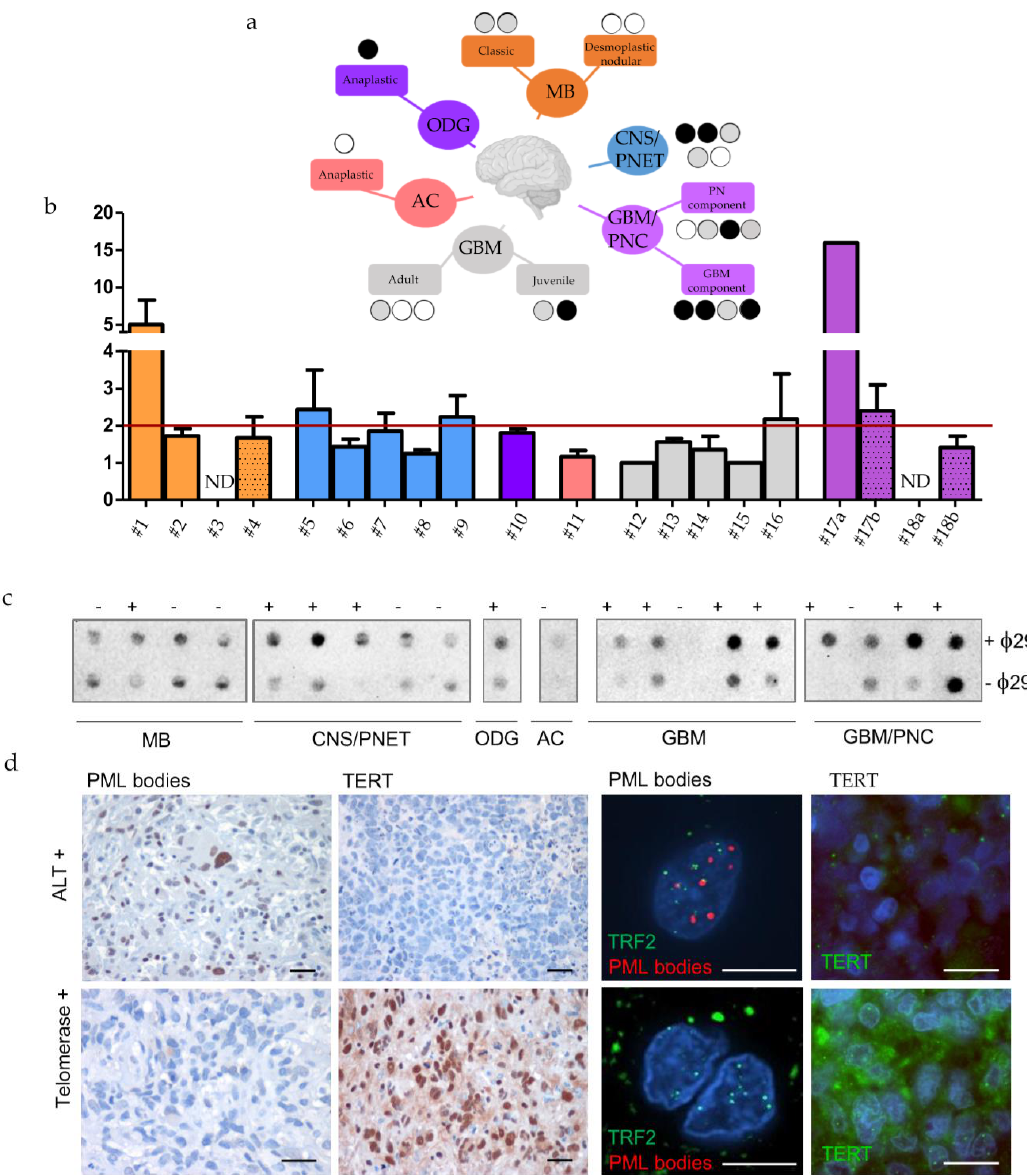
Figure 4. Identification of TMMs in a cohort of twenty human paediatric brain tumour. ( a ) Tree representation of the human cases analysed here and the TMMs identified. Black, grey and white circles indicates the results of CCA analysis (black: positive at 2 tests, grey: positive at 1 test and white: negative). ( b ) Identification of human brain tumors positive or negative for C-Circles, analysed by qPCR (Bars represent mean of fold changes +/- s.e.m of two independent experiments) and ( c ) dot blot. The red line shows the limit above which ALT is detected. MB = Medulloblastoma, CNS / PNET = Central Nervous System Primitive NeuroEctodermal Tumors, ODG = oligodendroglioma, AC = astrocytoma, GBM = glioblastoma, GBM-PNC = Glioblastoma with Primitive Neuronal Component. ( d ) Immunohistochemical and immunofluorescent stainings of PML bodies, TERT and PML bodies / TRF2 in two representative cases of juvenile brain tumors, ALT or telomerase + , as indicated. Calibration bars: 10 µm.